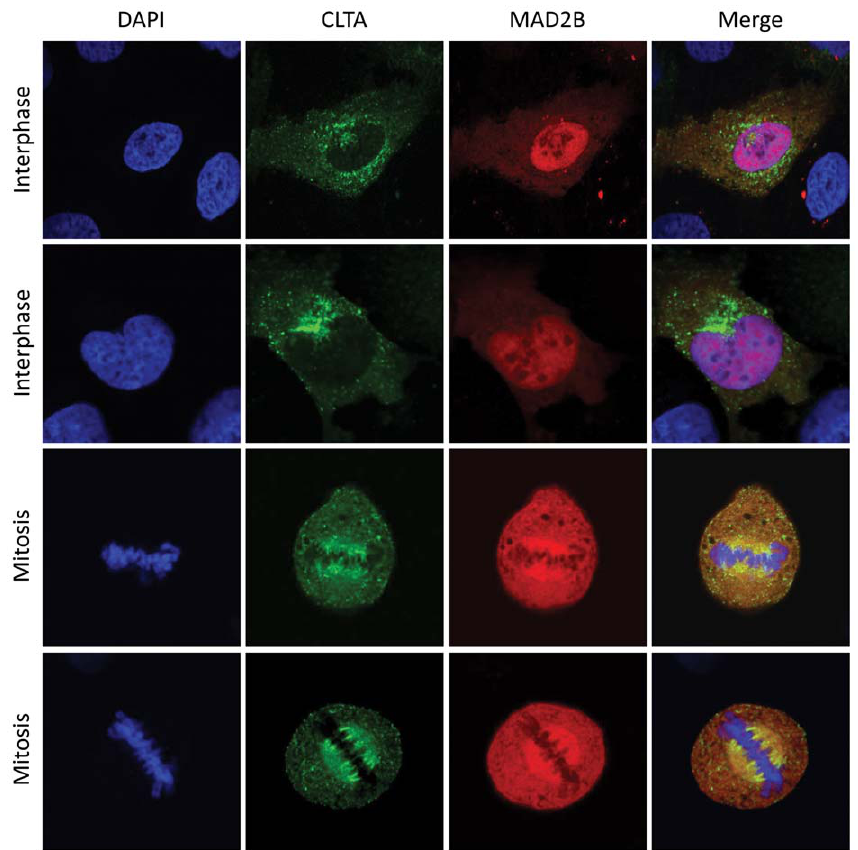
Figure 2. MAD2B and CLTA co-localize at the mitotic spindle. Cells were transiently transfected with CLTA-GFP (green) and MAD2B-mRFP (red) constructs. DAPI staining (blue) marks the position of the nuclei and chromosomes. Yellow staining in the overlay indicates co-localization of MAD2B and CLTA. The upper two panels show cells in interphase, the lower two panels show cells in mitosis.